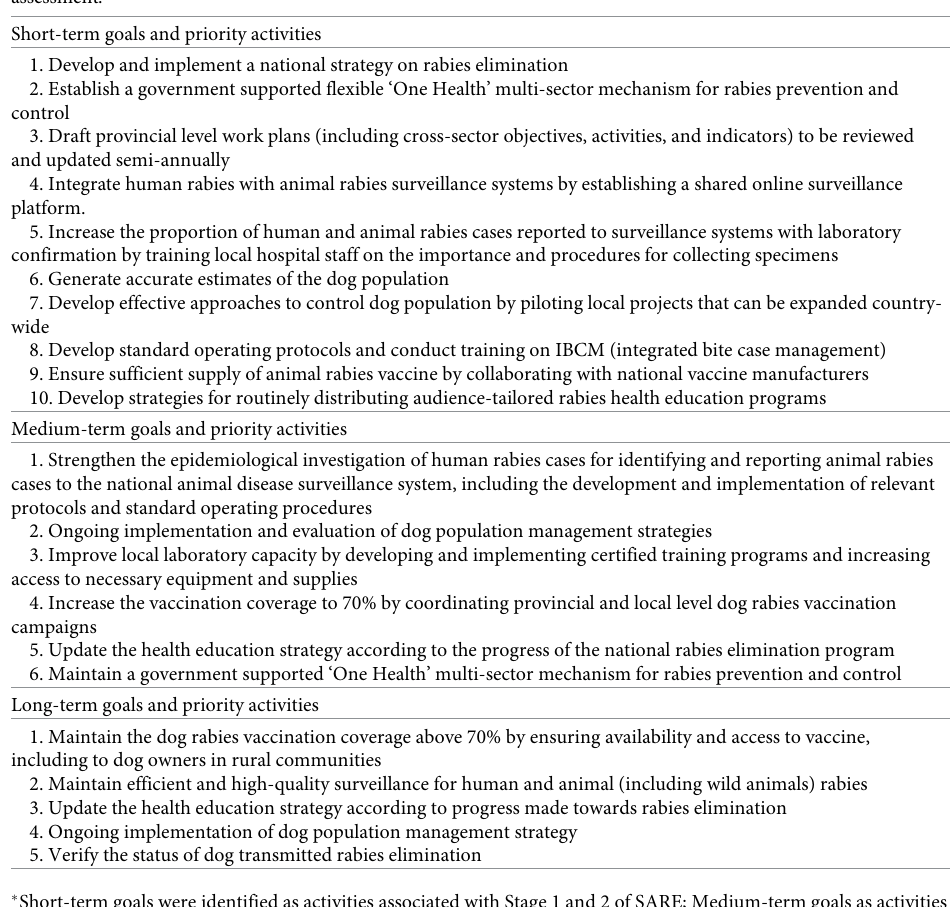
Table 3. Short-, medium-, long-term goals � and priority activities identified from Stepwise Approach towards Rabies Elimination (SARE) workshop participants representing national and 12 provincial level human and ani- mal health sector offices, March 2019. Goals and activities were identified following completion of the SARE